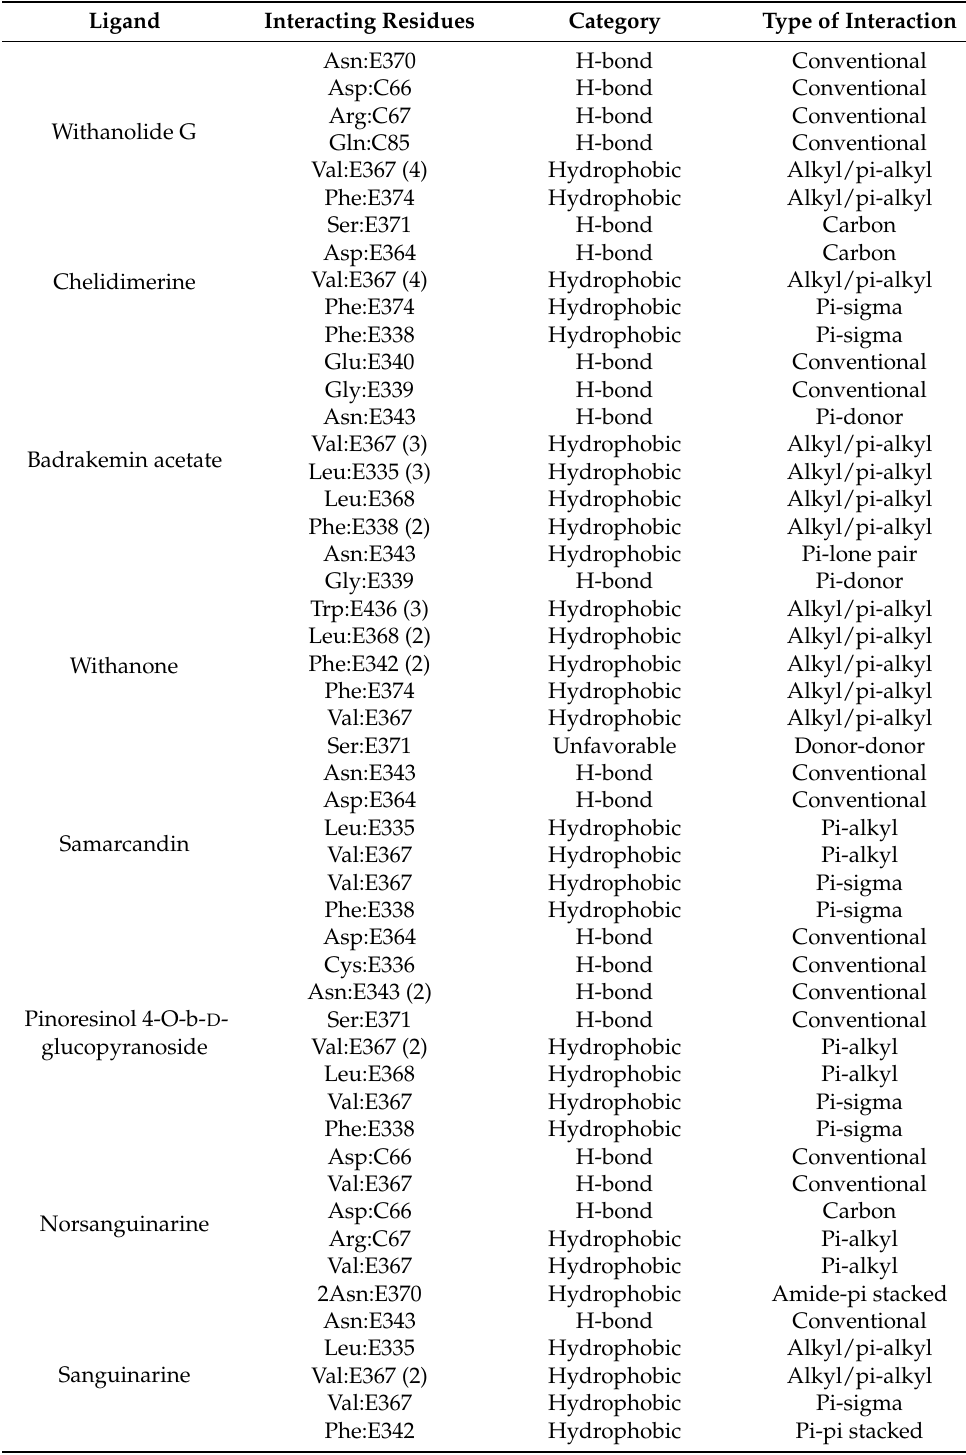
Table 3. Molecular interactions between the best ligands and the receptor-binding domain